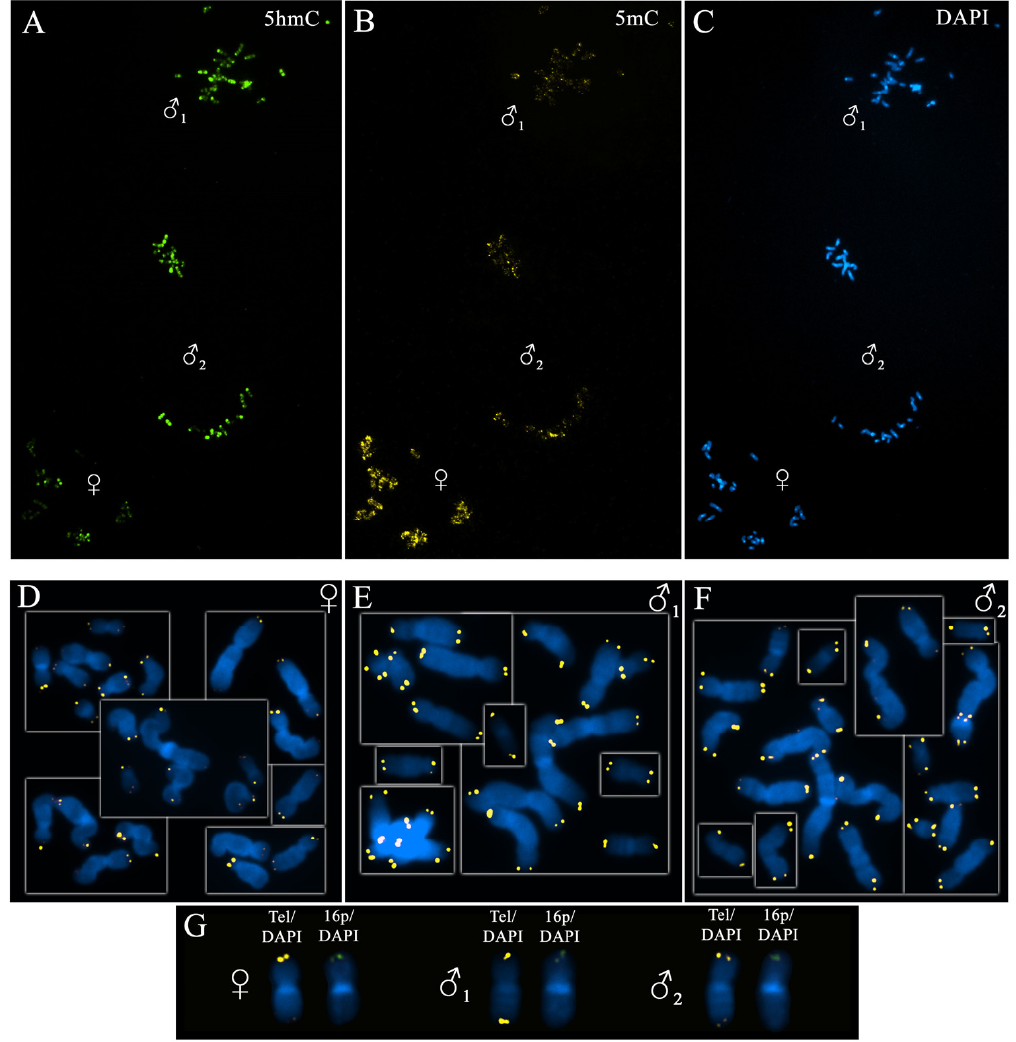
Figure 1. Parental origin identification and telomere detection in the metaphase chromosomes of a human triploid zy- gote. The chromosomes’ parental origin was determined through immunocytochemical staining with an- ti-5-hydroxymethylcytosine (5hmC) ( A ) and anti-5-methylcytosine (5mC) ( B ) antibodies and DAPI counterstaining ( C ) (magnification 10 × 20, var. × 0.63 for A – C ). Chromosomes from pronuclei of different parental origin show contrasting 5mC and 5hmC patterns: those from a maternal pronucleus are hypermethylated and hypohydroxymethylated, while those from the paternal pronuclei are hypomethylated and hyperhydroxymethylated. Telomeres in chromosomes from maternal ( D ) and paternal ( E , F ) pronuclei were detected through fluorescent in situ hybridisation (FISH) with telomeric DNA probes, and the chromosomes were stained with DAPI (magnification 10 × 100 for D – F ). Panel G shows three homologues of chromosome 16 from a maternal and two paternal pronuclei after FISH with telomeric (Tel/DAPI) and subtelomeric 16p (16p/DAPI) DNA probes.